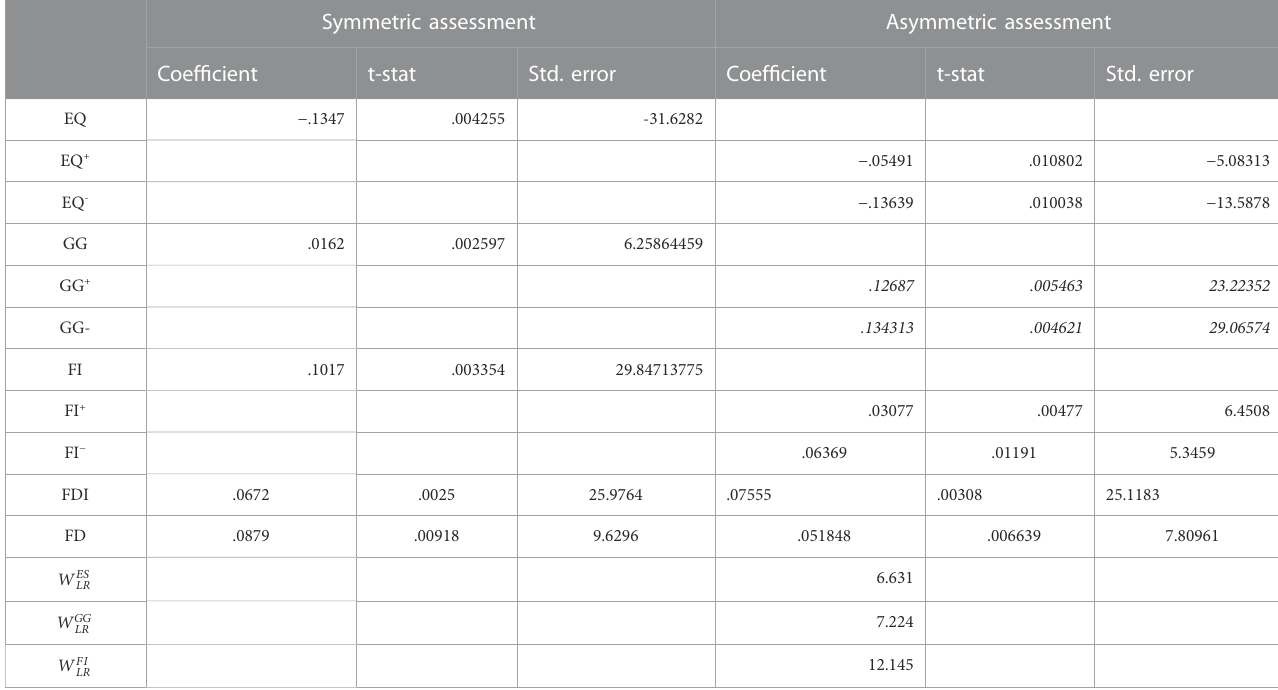
TABLE 8 Results of long-run coef fi cients: symmetric and asymmetric assessment. Symmetric assessment Asymmetric